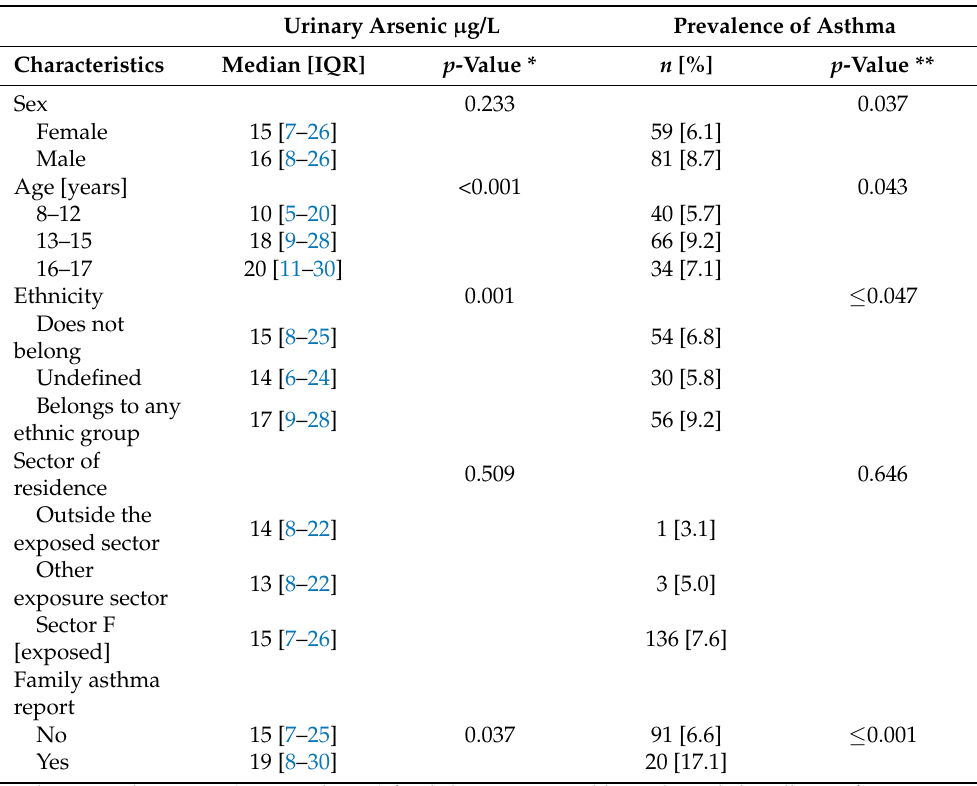
Table 2. Urinary arsenic concentration and prevalence of asthma according to individual characteris- tics, Arica